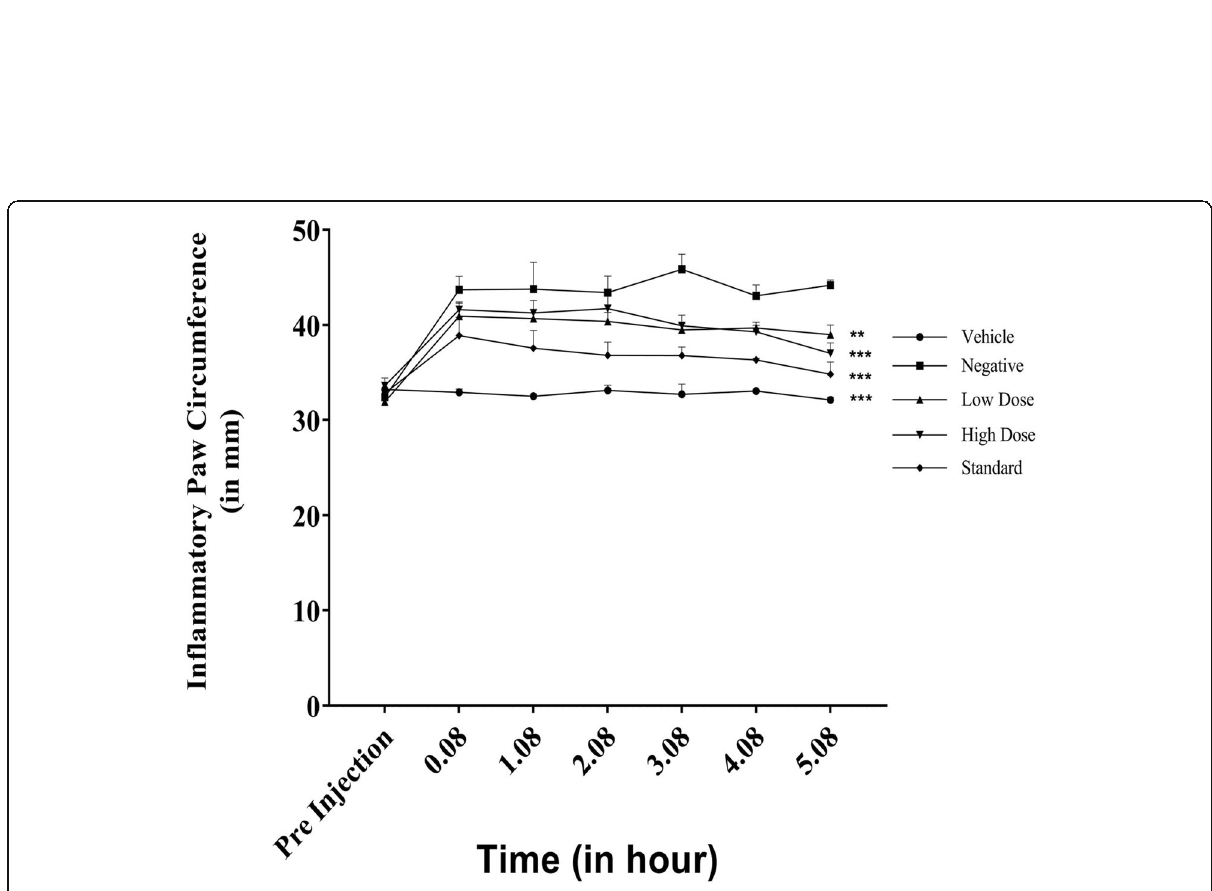
Fig. 4 Changes in paw circumference (in mm) in carrageenan-induced paw swelling test against time (in min) in different experimental animal groups where * = p < 0.05, ** = p < 0.01, and *** = p <